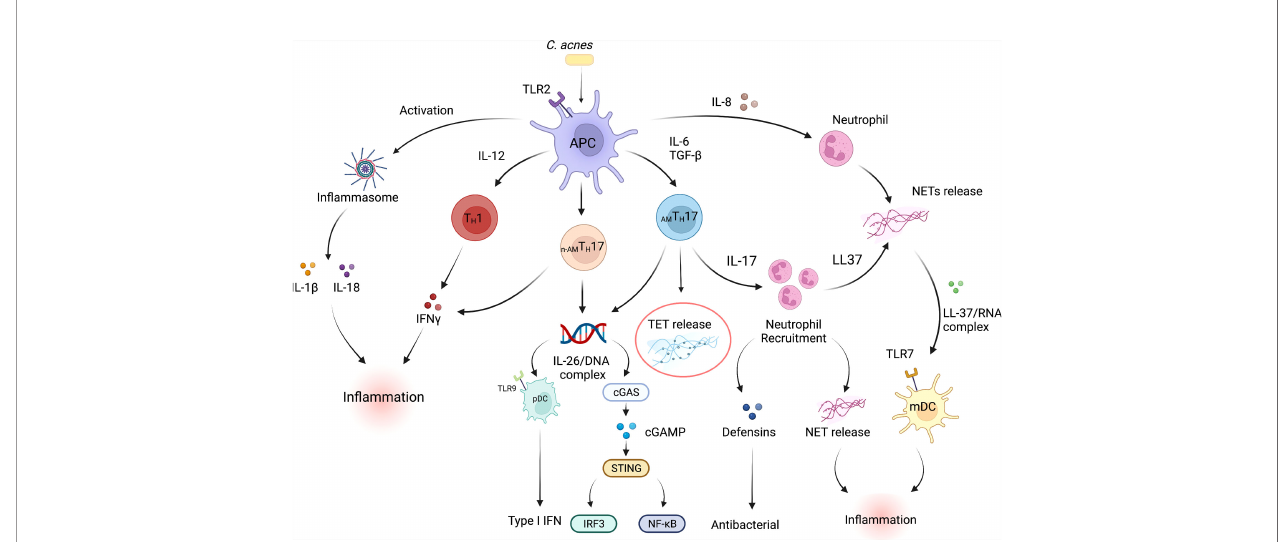
FIGURE 1 | In fl ammatory and antimicrobial pathways in acne vulgaris. Multiple interconnected innate and adaptive immune pathways contribute to skin in fl ammation associated with acne. C. acnes is the pre-dominant organism in the sebaceous region of the skin. Dysbiosis of the skin microbiome, C. acnes colonization or a disrupted homeostasis can upregulate the production of pro-in fl ammatory cytokines by skin-resident APCs such as dendritic cells, including high levels of IL-1 b , IL-6, IL-8, IL-12p70, and TGF b . Cytokines such as IL-6 and TGF b induce naive T cells to differentiate into effector T H 17 cells, whereas IL-12 drives a T H 1 differentiation program. C. acnes strains within the pilosebaceous unit can also in fl uence CD4 + T cell differentiation; C. acnes strains-associated with healthy skin promote the differentiation of naïve T cells into IL- 10-producing AM T H 17 cells whereas acne-associated strains promote the development of a non-antimicrobial T H 17 subpopulation ( n-AM T H 17). IL-8, IL-17, IL-26, LL-37 and TET production by immune cells within acne lesion promote neutrophil recruitment and increased antimicrobial activity. Expression of defensins can also drive antibacterial action. On the other hand, NET/TET release and formation of LL-37/RNA and/or IL-26/DNA complexes can activate both myeloid and plasmacytoid DCs leading to the production of proin fl ammatory cytokines that further promote in fl ammation (39). mtDNA can also activate the cGAS-STING pathway and production of type I IFNs (58, 59). C. acnes can also activate TLR2 receptor expression on macrophages and subsequent secretion of IL-1 b and IL-18 secretion in an in fl ammasome-mediated fashion. IFN- g release by T H 1 cells further drives the in fl ammatory responses within acne lesions. In addition, proin fl ammatory conditions exist when IFN- g -producing T H 1 cells are exposed to TNF- a and IL-12. APC, Antigen presenting cell; TGF b , Transforming growth factor- Beta; pDC, plasmacytoid dendritic cell; IFN- g , Interferon gamma; TLR, Toll-like receptor; mDC, myeloid dendritic cell; cGAS-STING, cyclic GMP-AMP synthase (cGAS)-stimulator of interferon genes (STING) pathway. Created with